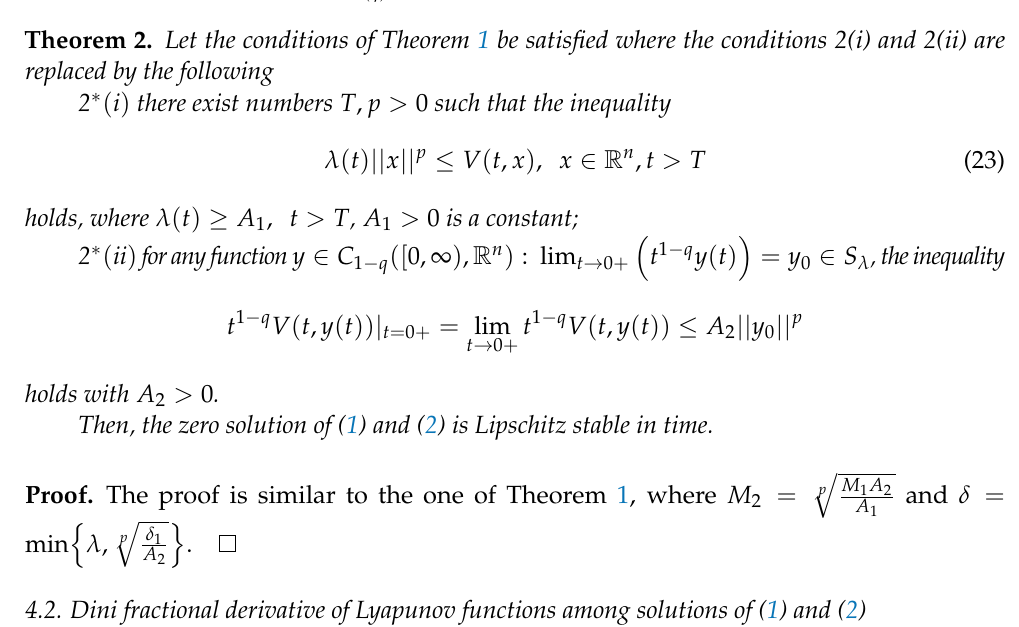
for various q ( q )